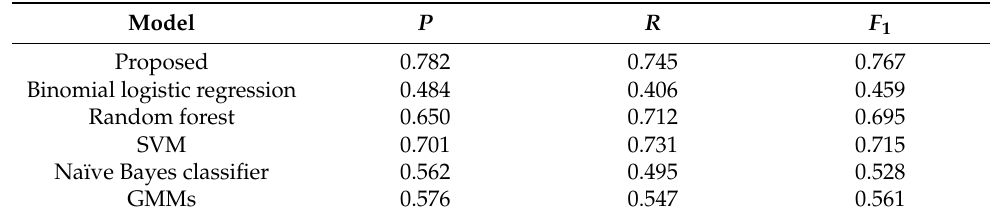
Table 9. Performance comparison of public online analysis models.